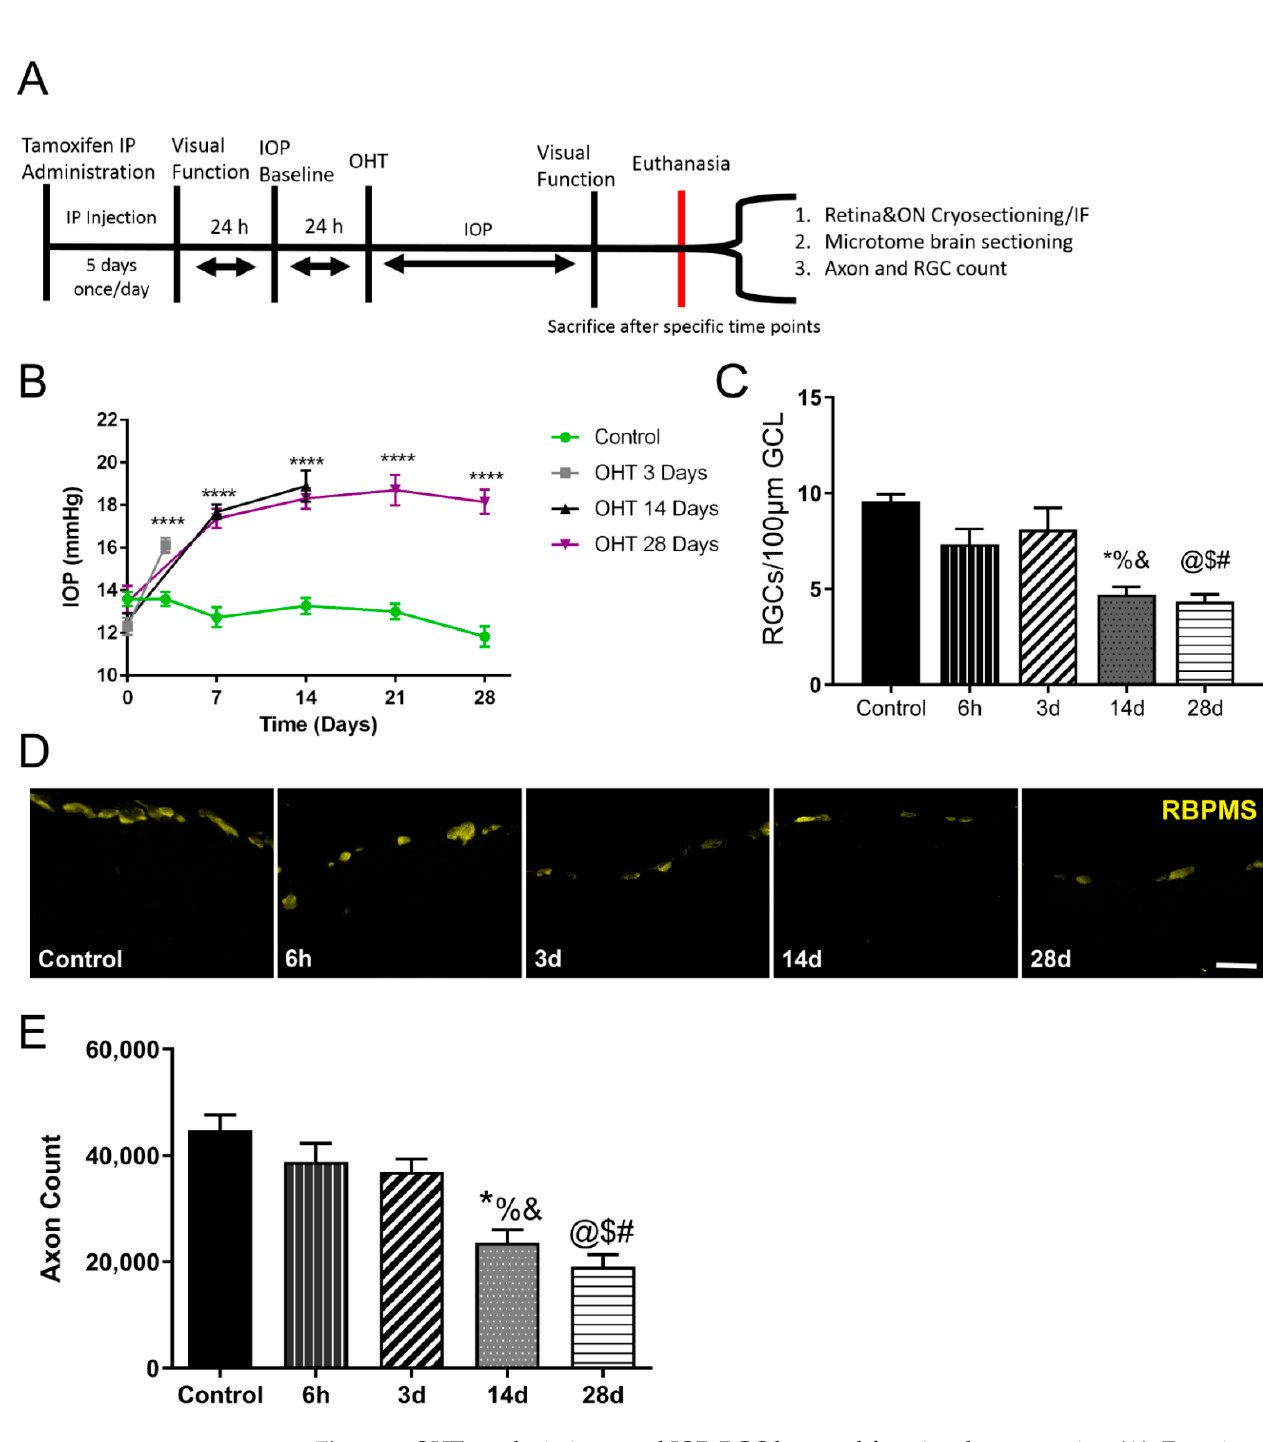
Figure 1. OHT results in increased IOP, RGC loss, and functional compromise. ( A ). Experimental design. Intraperitoneal injection of tamoxifen was administered to 2-month-old CAG-ODD transgenic mice. Visual evoked potential (VEP) and IOP were measured before and after 3, 14, and 28 days of OHT induction. OHT was induced by magnetic bead intracameral injection. Mice received an IP injection of 60 mg/kg pimonidazole, then were sacrificed 90 min later to compare and assess hypoxia using tdTomato (tdT) expression and pimonidazole (pimo) methods at 6 h, 3 days, 14 days, and 28 days after OHT in the retina, ON and visual centers in the brain. ( B) . A significant IOP elevation was detected (****, p < 0.0001) 3, 14, and 28 d after OHT. n = 16 eyes at 3 d, 14 eyes at 14 d, 12 eyes at 28 d, and 30 control eyes. ( C ). A significant decrease (F (4, 75) = 17.51) in RGC count per GCL was shown 14 d after OHT compared to control (%, p < 0.0001), 6 h (*, p < 0.0332), and 3 d (&, p = 0.0026). In addition, a significant decrease was detected in RGC count per µm GCL 28d after OHT compared to control (@, p < 0.0001), 6h ($, p = 0.0052), and 3d (#, p = 0.0002); n=12 eyes at 6 h, 12 eyes